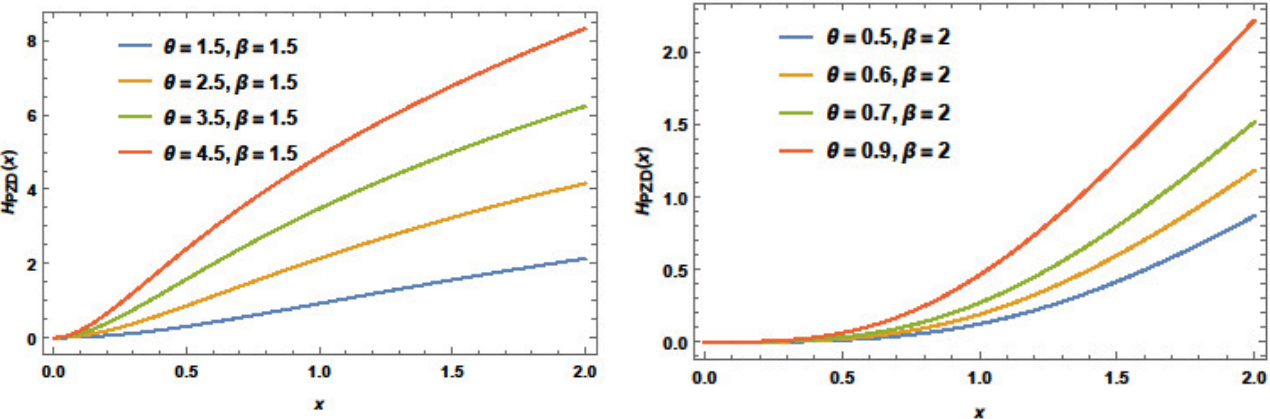
Figure 5. The hazard function plots of PZD for various values of parameters.